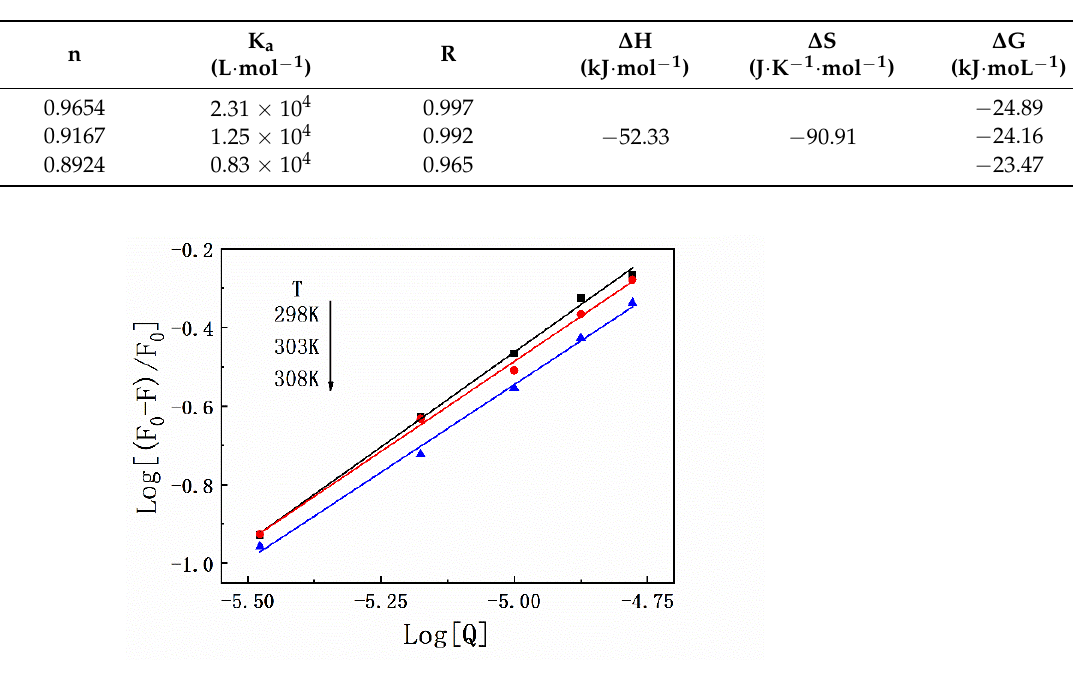
Table 1. Thermodynamic constants of interaction between SMT and HSA at different temperatures.